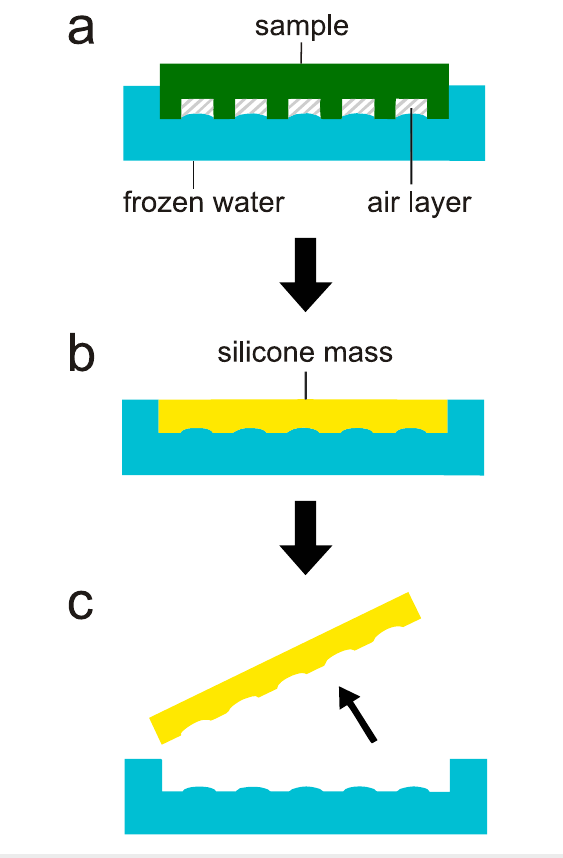
Figure 7: Scheme of the replication of the air–water interface. a) A Salvinia leaf is placed upside down on water and the assembly is cooled to − 32 °C afterwards. b) After removing the leaf specimen the imprint in the frozen water was filled with cooled silicone. c) After two days the polymerized silicone was